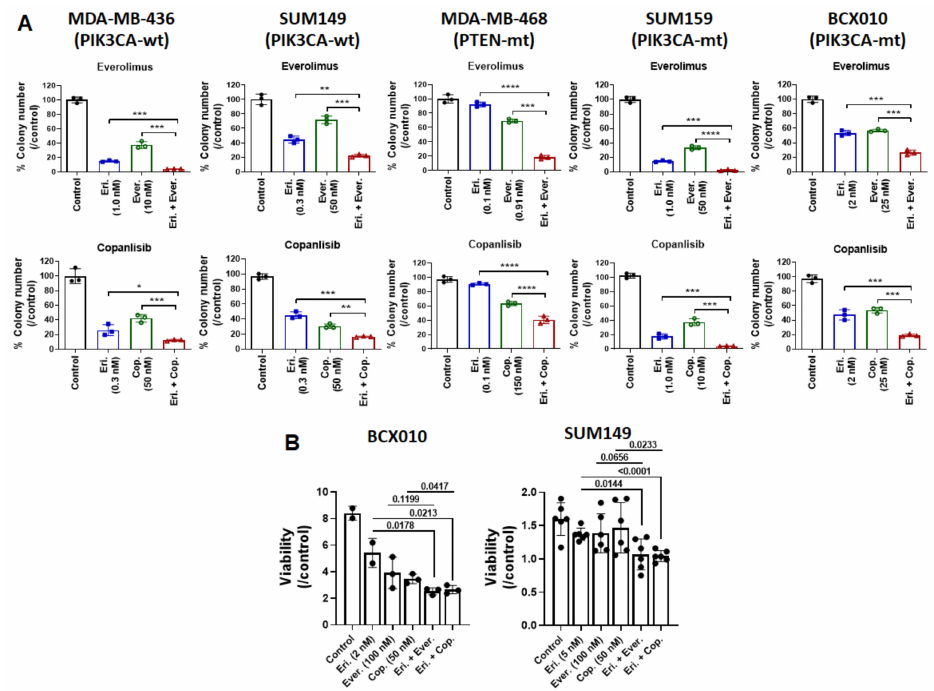
Figure 4. Combination of eribulin with everolimus or copanlisib is more effective than monotherapies at inhibiting TNBC cell growth. The synergistic effects of combination treatment were determined using ( A ) a soft agar colony formation assay at weeks 3 or 4 and ( B ) an ex vivo model following treatment with eribulin alone, everolimus alone, copanlisib alone, eribulin plus everolimus, or eribulin plus copanlisib. Data are presented as mean ± standard deviation. In ( A ), colony numbers are presented as percentage of non-treated control cells. *, p < 0.05; **, p < 0.01; ***, p < 0.001, ****, p < 0.0001 by two-tailed Student t -test. Eri., eribulin; Ever., everolimus; Cop., copanlisib; mt, mutated; wt,